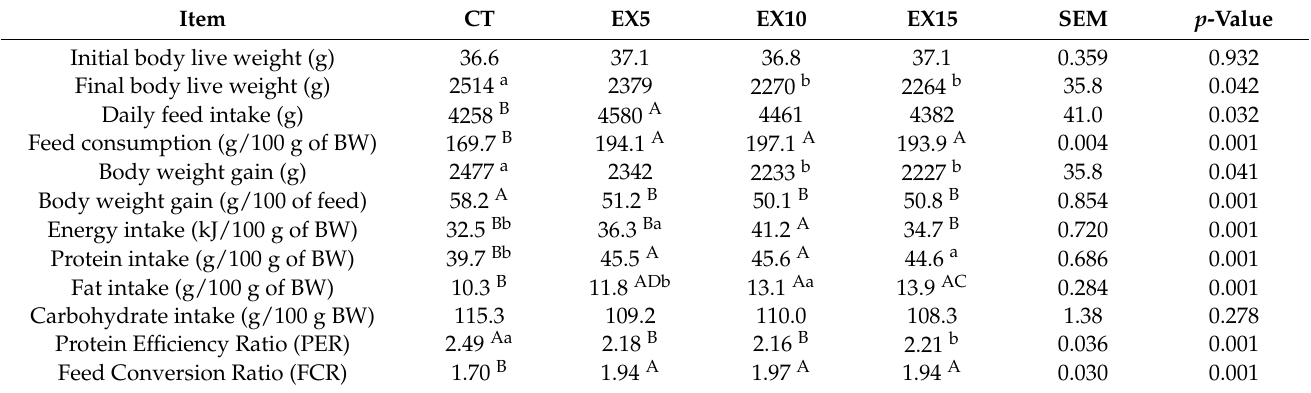
Table 4. Feed intake and body weight gain in male 43-day-old Ross-308 broilers (Mean, SEM, n